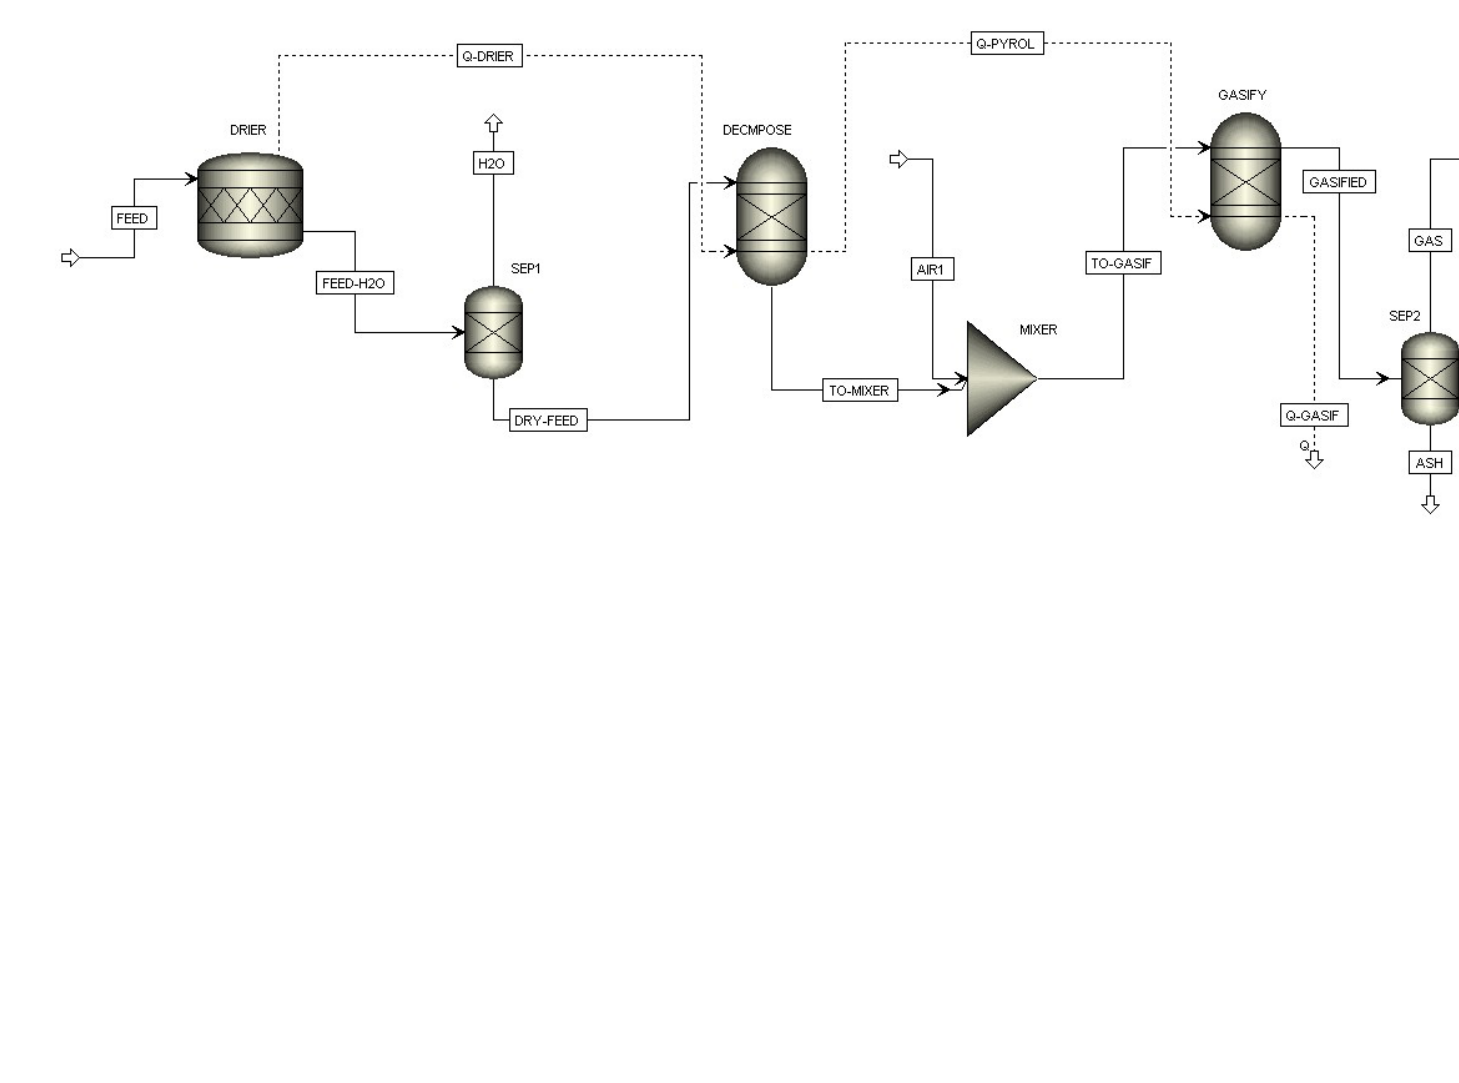
Figure 2. Advanced System for Process ENgineering (Aspen) Plus simulation